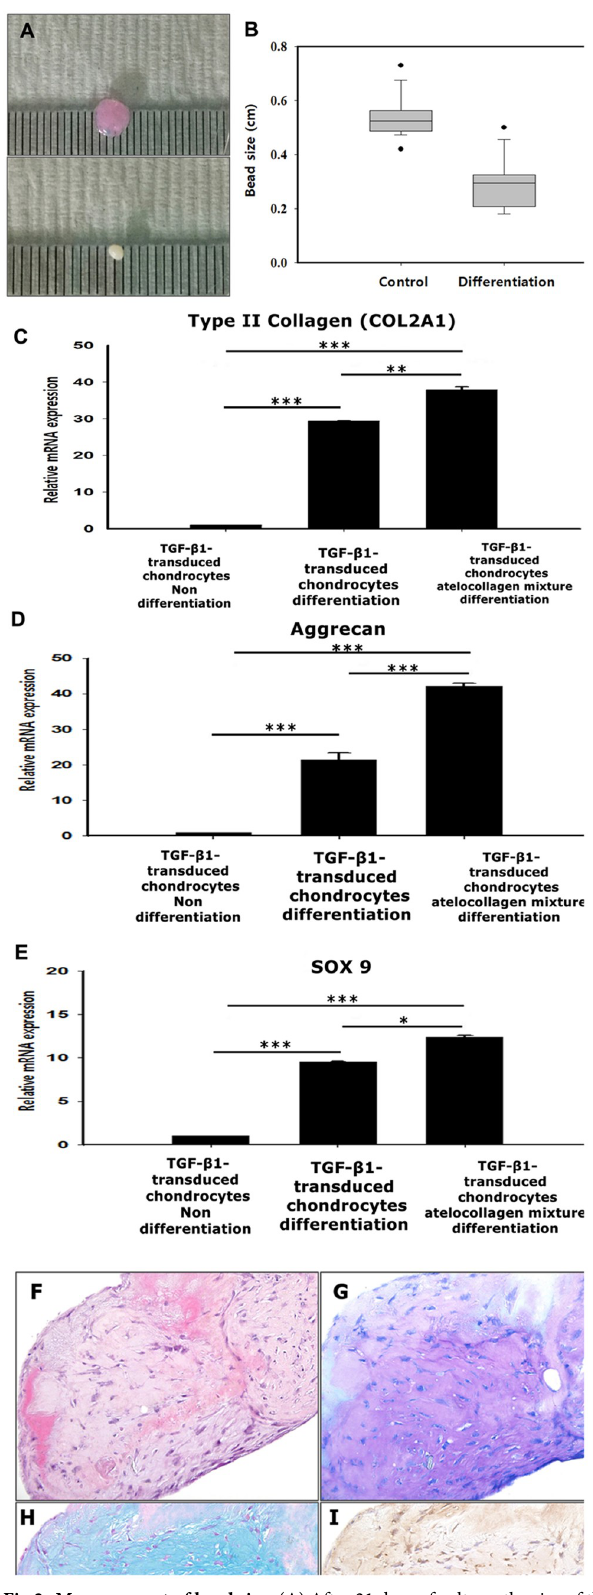
Fig 2. Measurement of bead size. (A) After 21 days of culture, the size of the TGF- β 1-transduced chondrocyte- atelocollagen mixture beads (upper) under non-differentiation and (lower) and chondrogenic differentiation conditions was compared. (B) The size of the TGF- β 1-transduced chondrocyte-atelocollagen mixture beads under